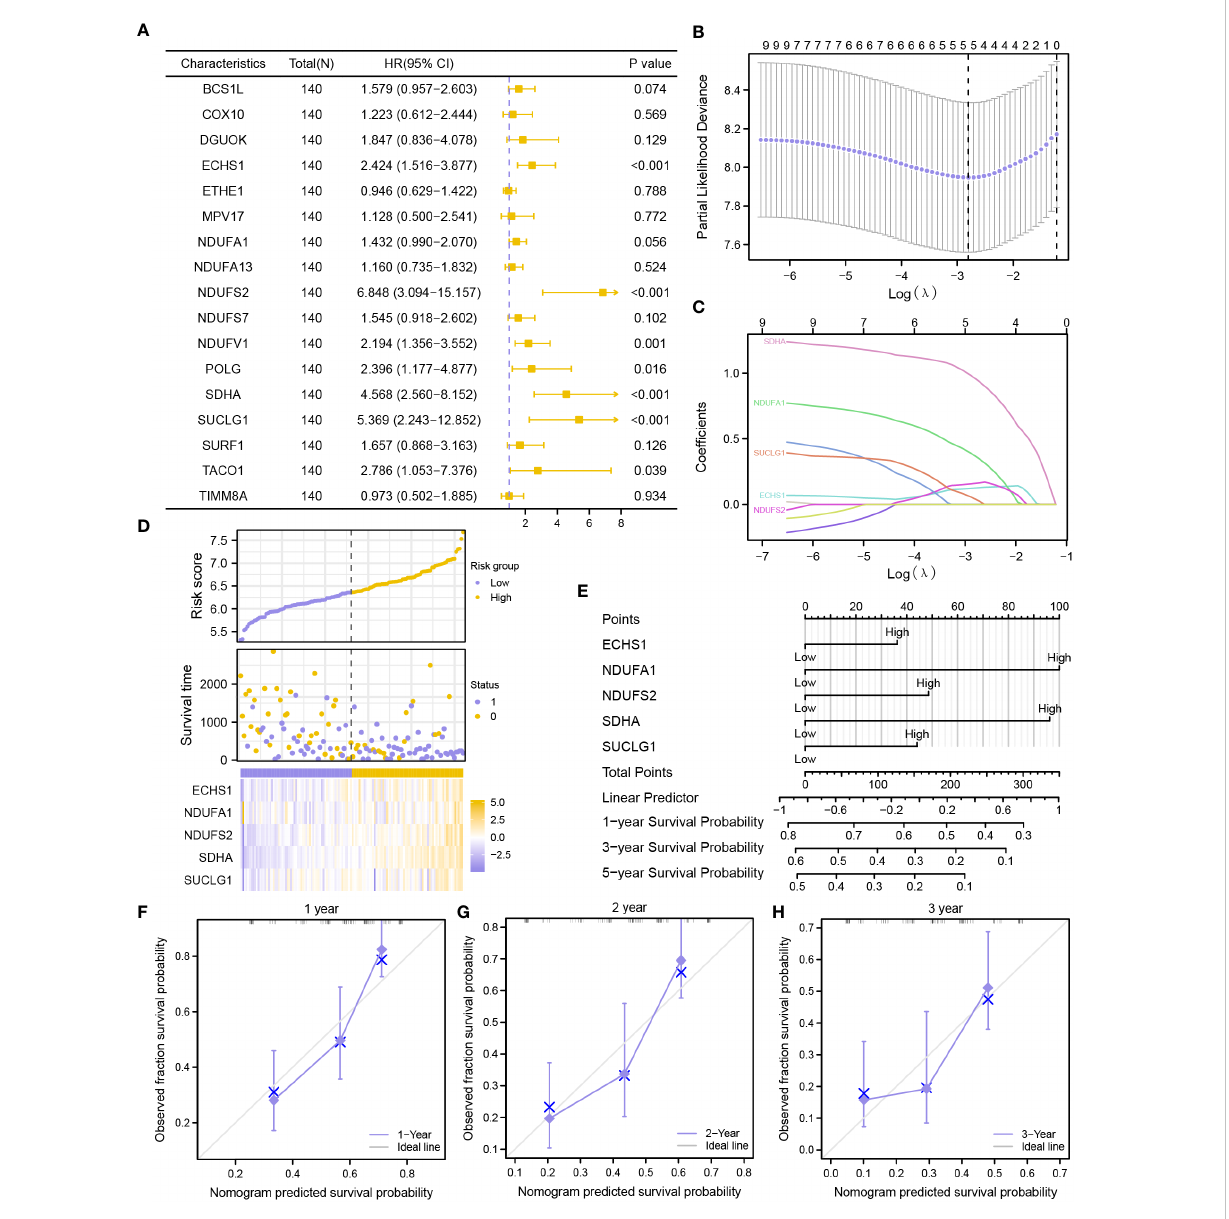
FIGURE 5 Construction of a prognostic risk signature based on MMRGs. (A) The forest plot showing the univariate Cox regression results of 17 module MMRGs in the TCGA-LAML dataset. (B, C) . Partial likelihood deviance of different numbers of variables (B) , and coef fi cient pro fi les (C) for the LASSO regression model. (D) Distribution of risk scores and survival status, and expression of fi ve MMRGs. (E) A nomogram for multivariate Cox regression analysis of prognostic MMRGs. (F-H) . Calibration curves of the MMRGs prognostic model for 1-, 2-, and 3-year